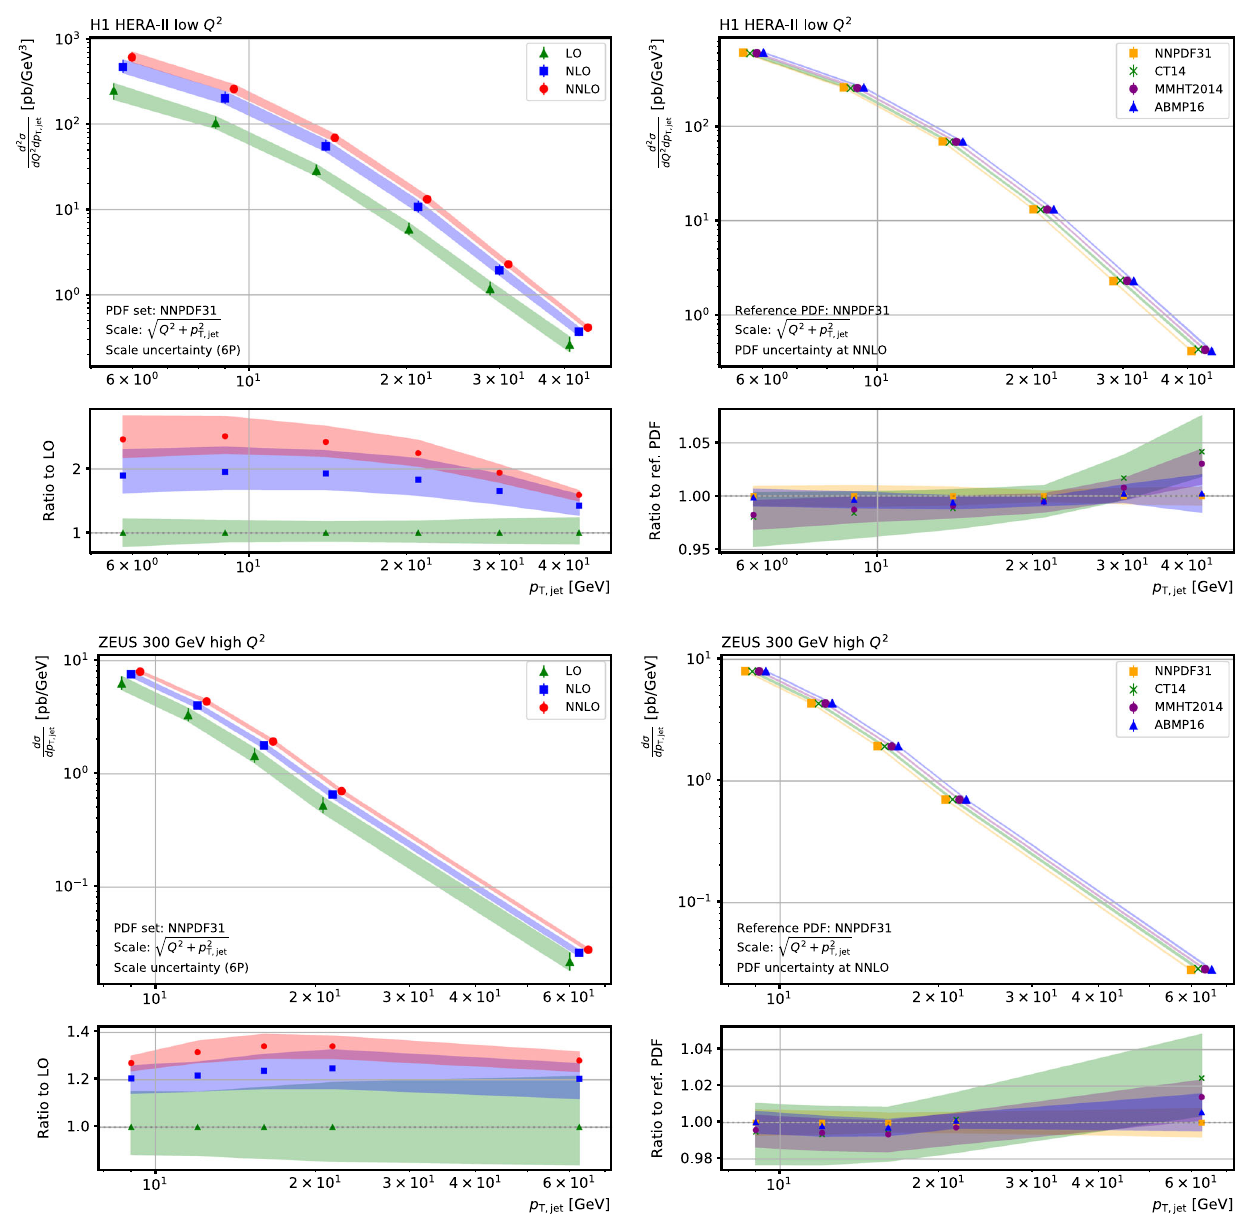
Fig. 4 Inclusive jet cross section as a function of the jet p T for two ranges in Q 2 : 30 < Q 2 < 42GeV 2 for H1 data (upper row), and 500 < Q 2 < 1000GeV 2 for ZEUS data (lower row). On the left the LO, NLO, and NNLO predictions are shown using the NNPDF31 PDF set including their ratio to the LO in the respective lower panels. On the right the NNLO predictions are shown for the four PDF sets